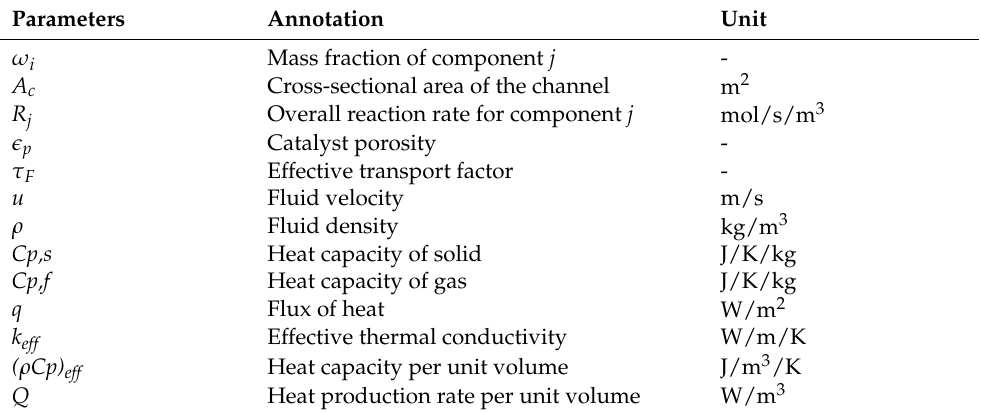
Table 1. Parameters applied in the Equations (1)–(12).